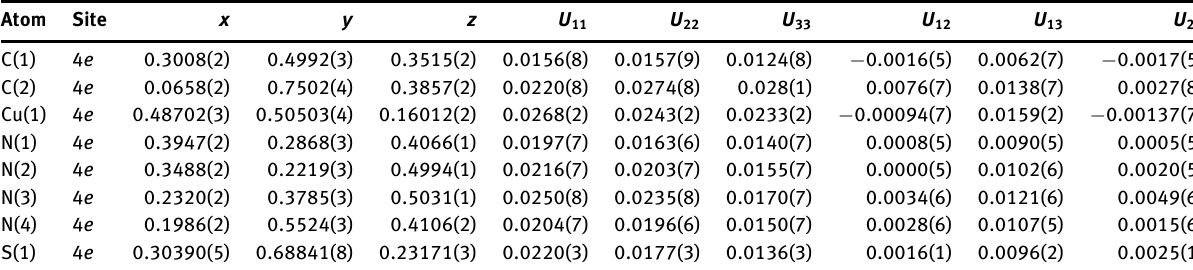
Table 3: Fractional coordinates and atomic displacement parameters (Å 2